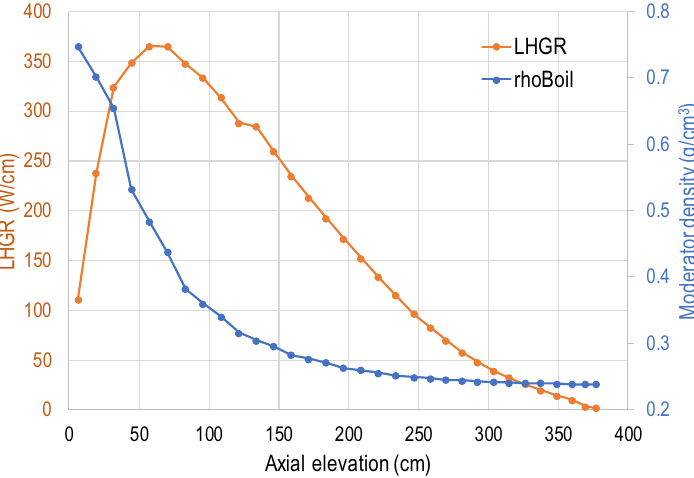
Figure 4. Radially averaged power density (orange) and moderator density (blue) axial profiles within a SVEA-96 Optima2 assembly (LHGR: linear heat generation